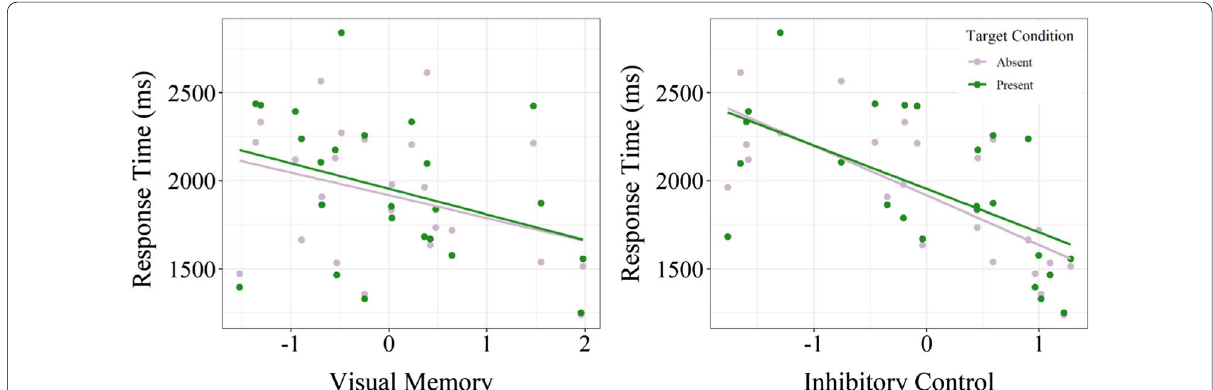
Fig. 7 Response times for target-absent (purple) and target-present (green) trials in relation to z -score transformed individual differences for visual memory (left) and inhibitory control (right). Higher scores for both measures were associated with faster response